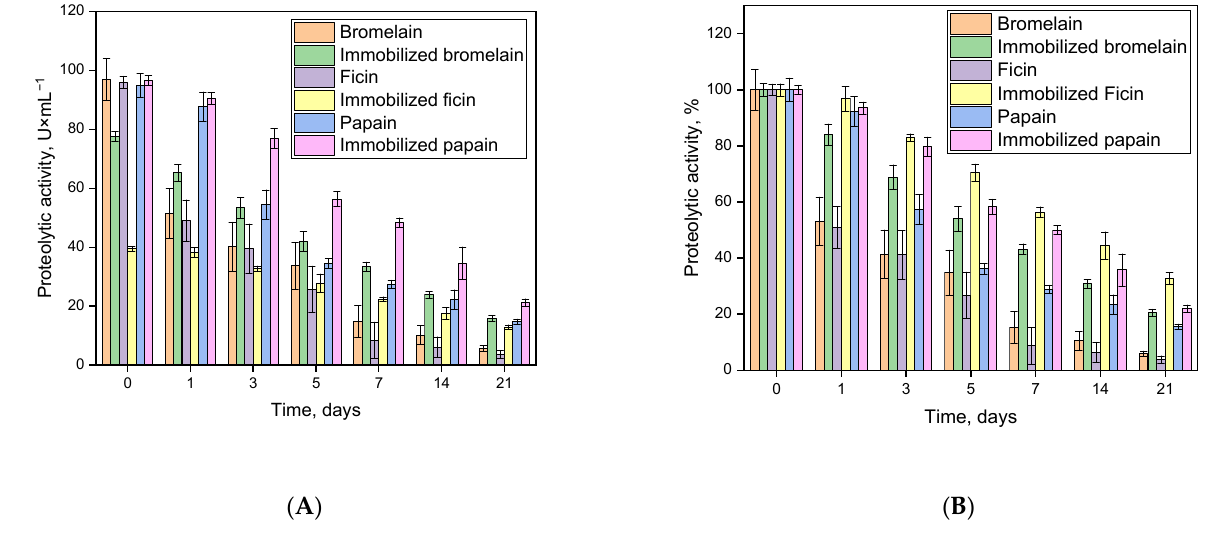
Figure 4. The remain catalytic activity of the native or immobilized enzyme in U × mL − 1 ; ( A ) or in % ( B ) after incubation at 37 °C, 50 mm Tris-HCl, pH 7.5. Table 5. The enzyme animo acid residues interacting with Cht- g